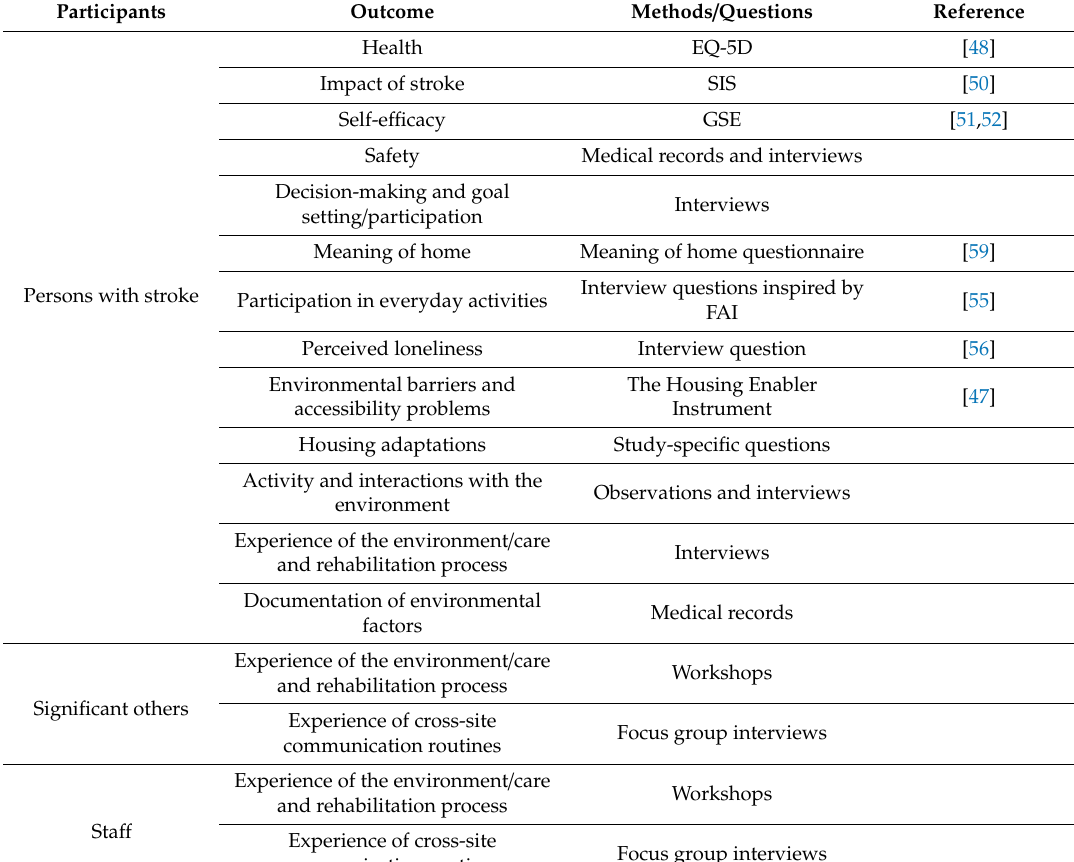
Table 1. Overview of participants, outcomes, methods and